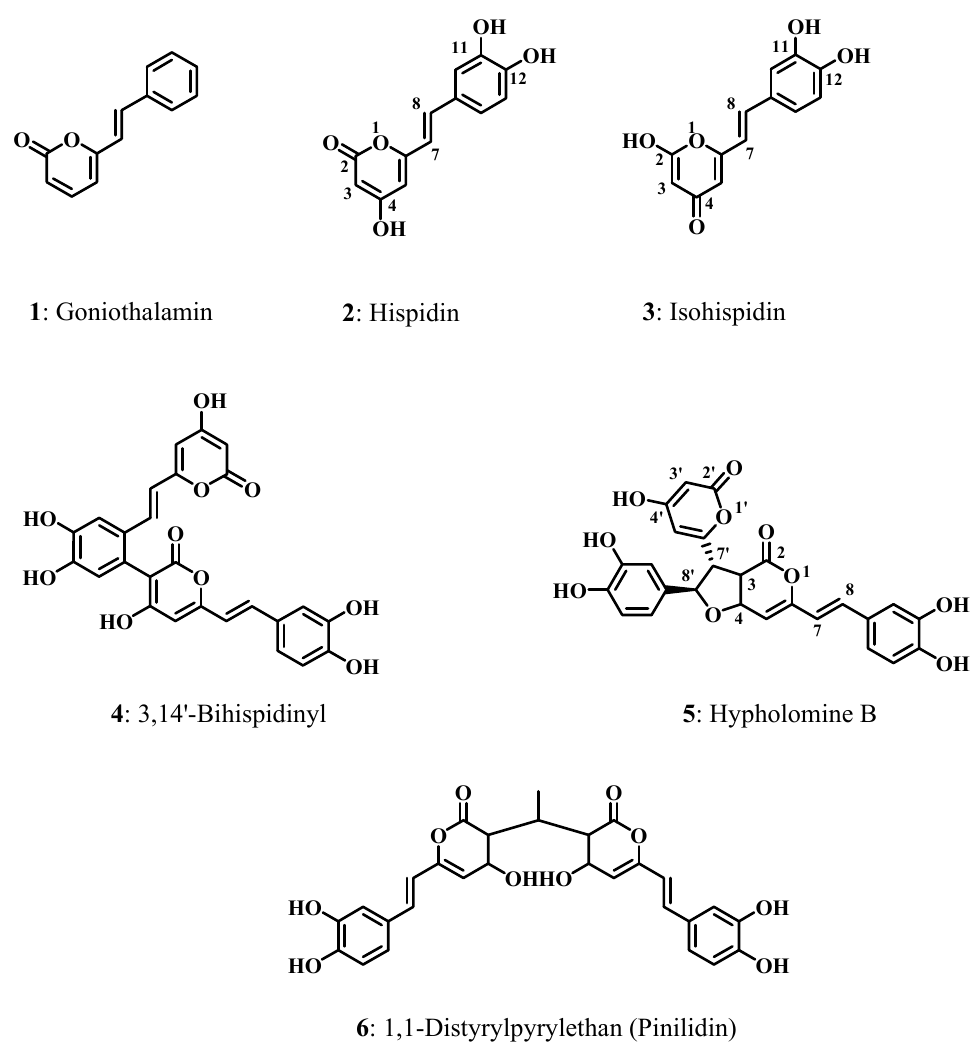
Figure 1. Molecular structures of compounds 1 – 6